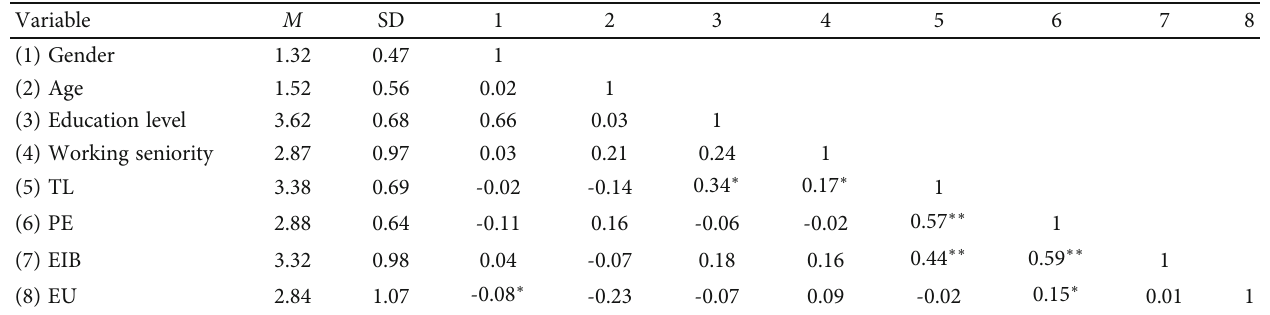
Table 2: Descriptive statistics and Pearson correlation of research variables.